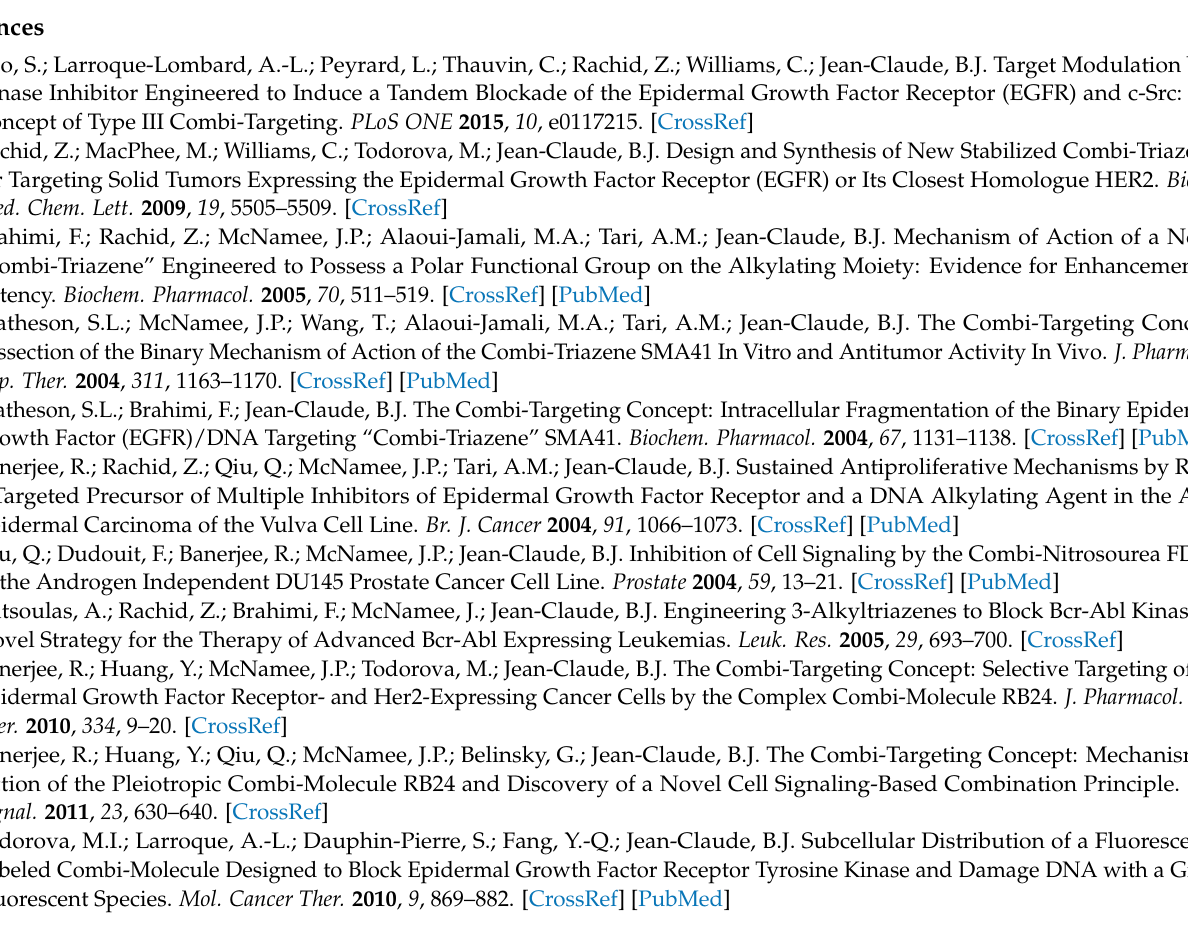
Figure A3. Main metabolites released in the plasma after 3 h from combi-molecule administration. ( A ) LC-MS chromatogram of the metabolization of ZR2002 (first row), JS61 (middle row) and JS84 (bottom row). Metabolites: (1) RB10, (2) RB10-N-Acetyl, (3) ZR2002, (4) JS61-OH-Cl, (5) JS61-OH-2Cl, (6) RB10-N-Acetyl-Methyl, (7) RB10-Methyl and (8) JS84-OH-Cl. The peak of JS61 intact drug is in green, while JS84’s is in blue, and ZR2002’s is in red. ( B ) Quantification of ZR2002 released in the treated tumors. Data are expressed as means ± SEM. * p < 0.05 between the two groups.